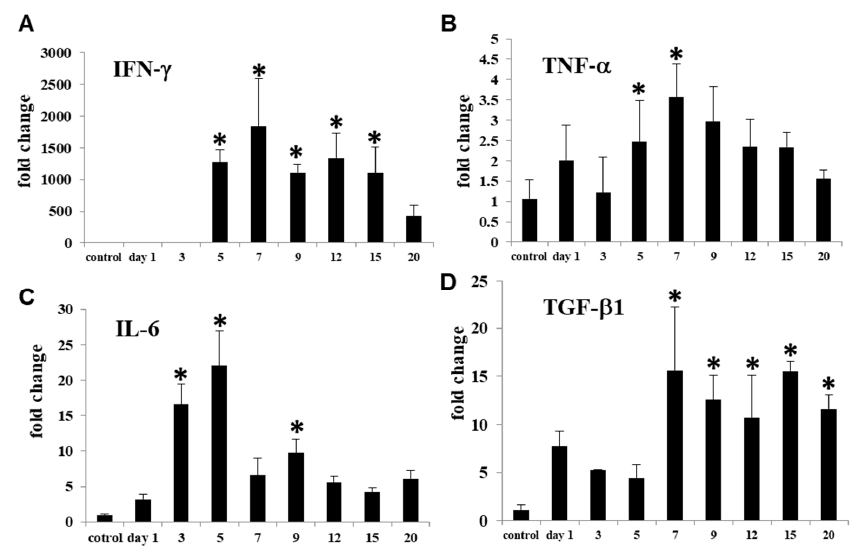
Figure 7. mRNA expressions for M1-related factors such as IFN- γ ( A ), TNF- α ( B ) and IL-6 ( C ), and for M2-related factor TGF- β 1 ( D ) in the control and CDDP-treated kidneys on days 1–20. Expression levels were normalized by β -actin RNA level. Dunnett’s test, *, significantly different from controls at p < 0.05.